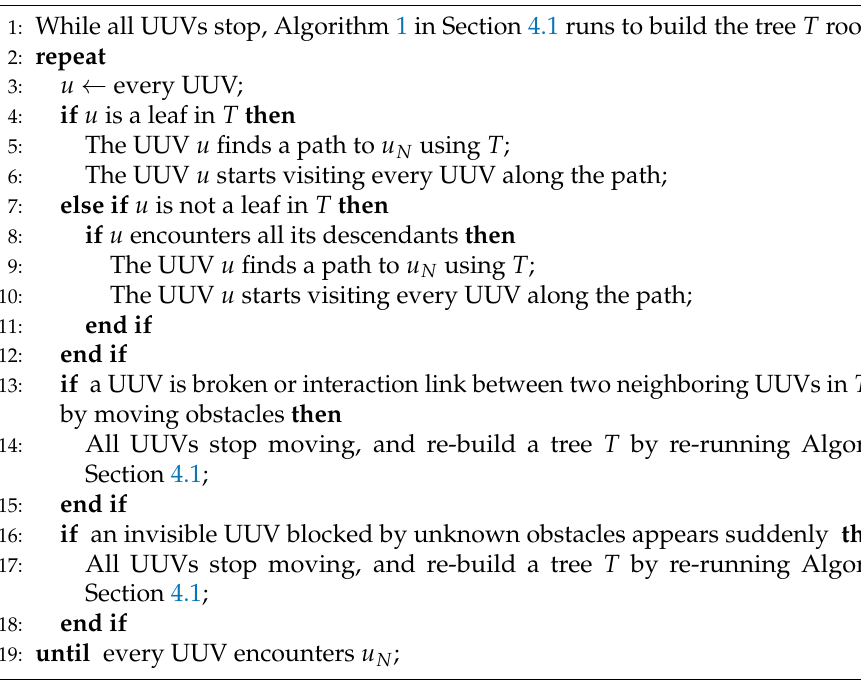
Algorithm 2 Distributed rendezvous